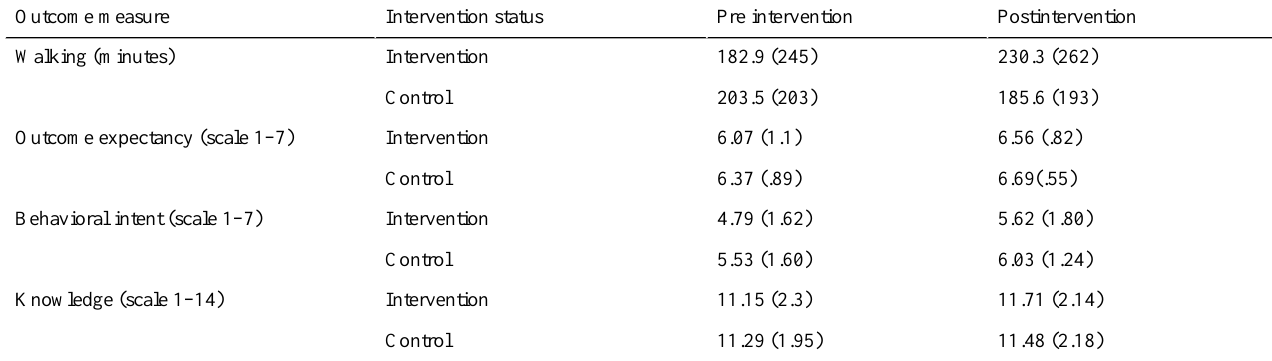
Table 5. Means (SD) for all outcome measures pre- and